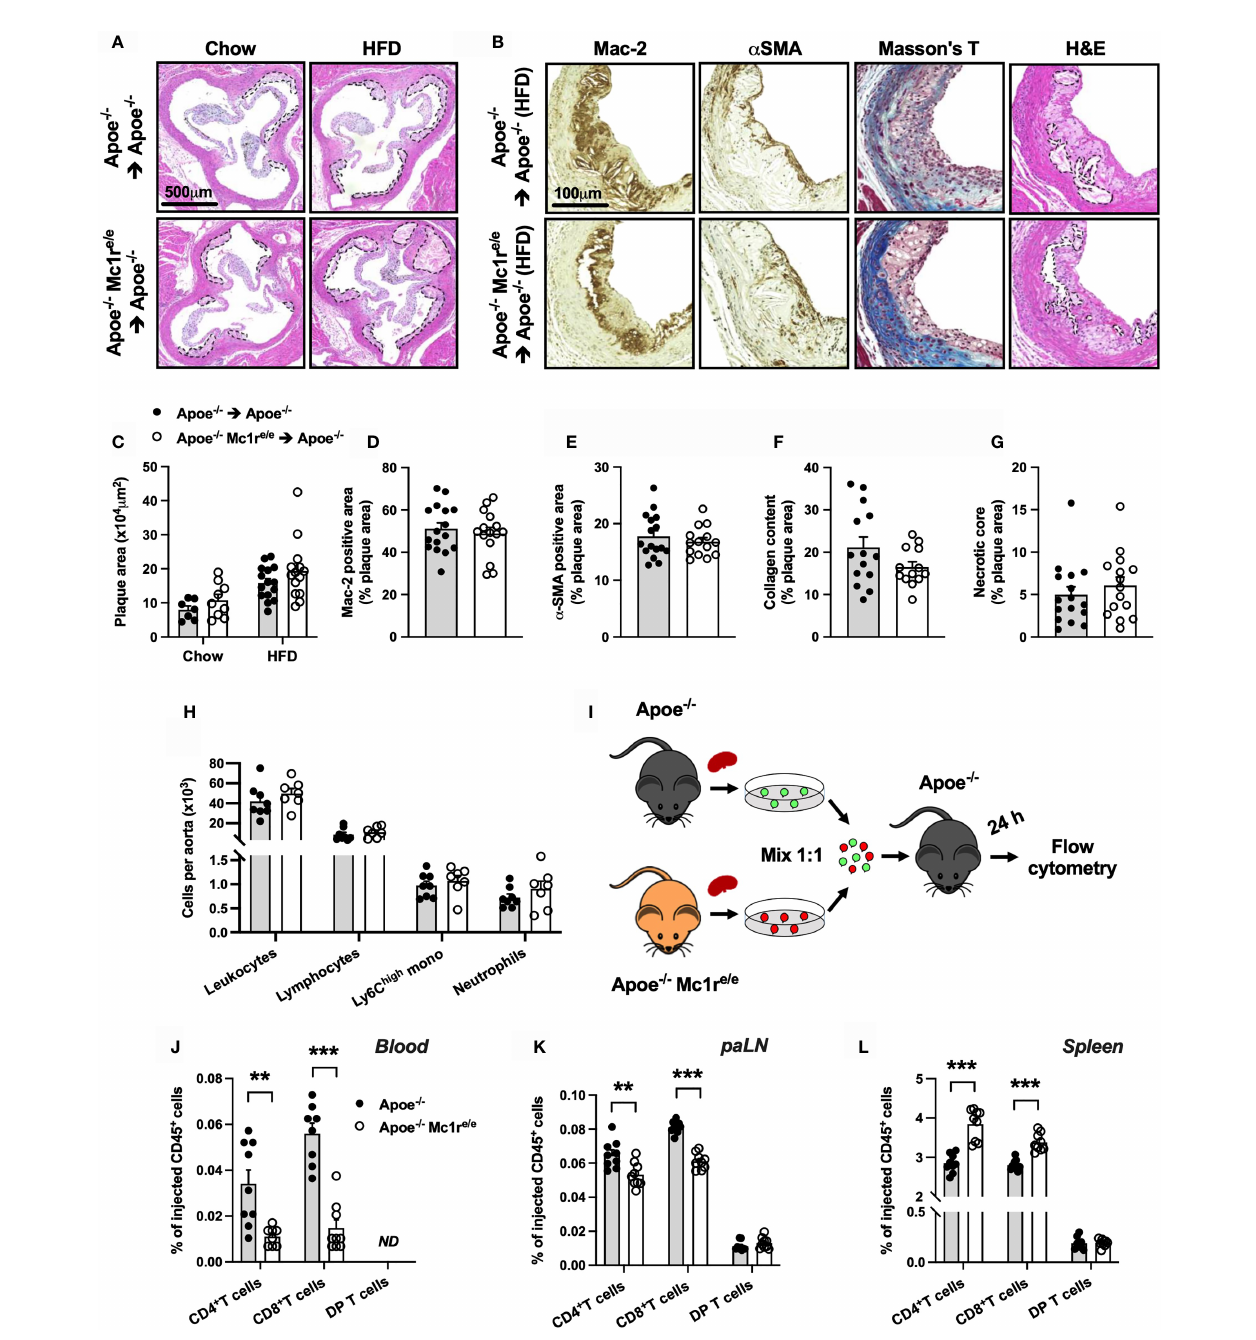
FIGURE 4 | Hematopoietic MC1-R de fi ciency does not affect plaque phenotype but signi fi cantly alters homing behavior of T cells. (A) Representative images of hematoxylin and eosin (H&E) staining of the aortic sinus of Apoe -/- and Apoe -/- Mc1r e/e BM engrafted mice on chow or HFD for 10 weeks. (B) Representative images of Mac-2 (galectin-3), a -SMA ( a -smooth muscle actin), Masson trichrome staining and necrotic core areas in the aortic sinus. Necrotic core areas are indicated with dashed lines in H&E-stained images. (C) Quanti fi cation of plaque area in aortic sinuses. (D – G) Quanti fi cation of Mac-2- and a -SMA – positive areas, plaque collagen content and acellular necrotic core areas as percentage of total plaque area. (H) Quanti fi cation of total leukocytes (CD45 + ), lymphocytes (CD45 + , CD11b - ), Ly6C high monocytes (CD45 + , CD11b + , CD115 + , Ly6C high ) and neutrophils (CD45 + , CD11b + , Ly6G + ) by fl ow cytometry in the aorta of Apoe -/- recipient mice. (I) Experimental design for analyzing homing of different lymphocyte subsets to the para-aortic lymph nodes (paLN) and spleen. Cells were isolated from the spleen of Apoe -/- and Apoe -/- Mc1r e/e mice and injected into recipient Apoe -/- mice. (J – L) Quanti fi cation of CD4 + T cells (CD45 + , TCR b + , CD4 + ), CD8 + T cells (CD45 + , TCR b + , CD8 + ) and double positive (DP) T cells (CD45 + , TCR b + , CD4 + , CD8 + ) by fl ow cytometry in the blood, paLNs and spleen as percentage of injected CD45 + cells. Data are mean ± SEM, **P < 0.01, ***P < 0.001 versus control Apoe -/- mice. Each dot represents individual